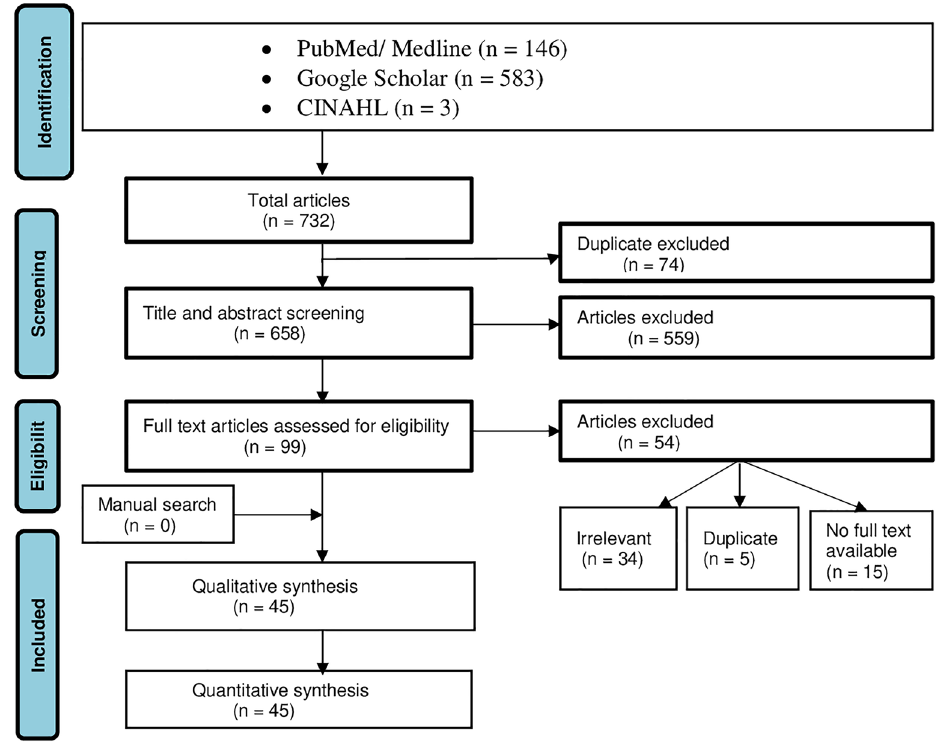
Figure 1. PRISMA flow diagram studies screening, and selection on computer vision syndrome,